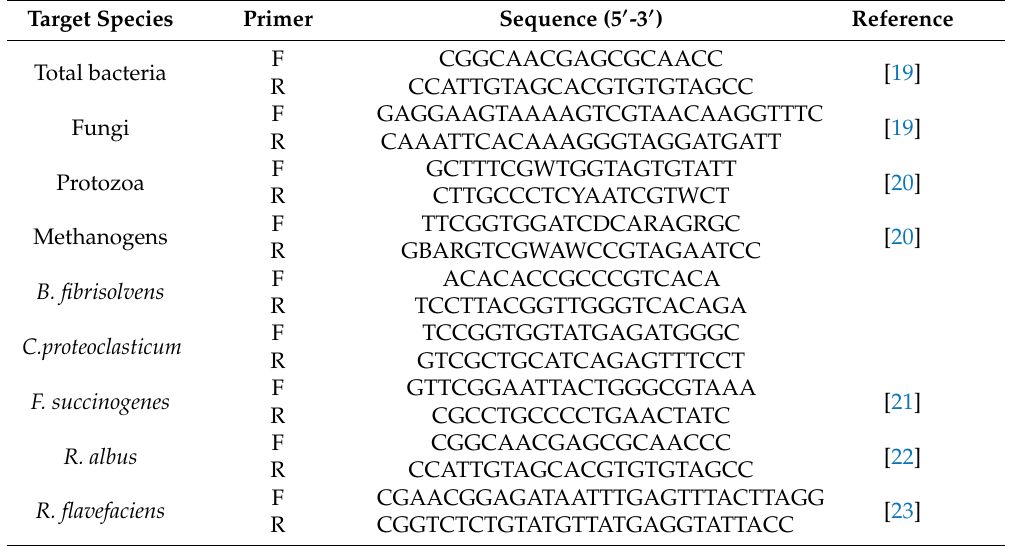
Table 2. Primers for real-time PCR assay (used in this